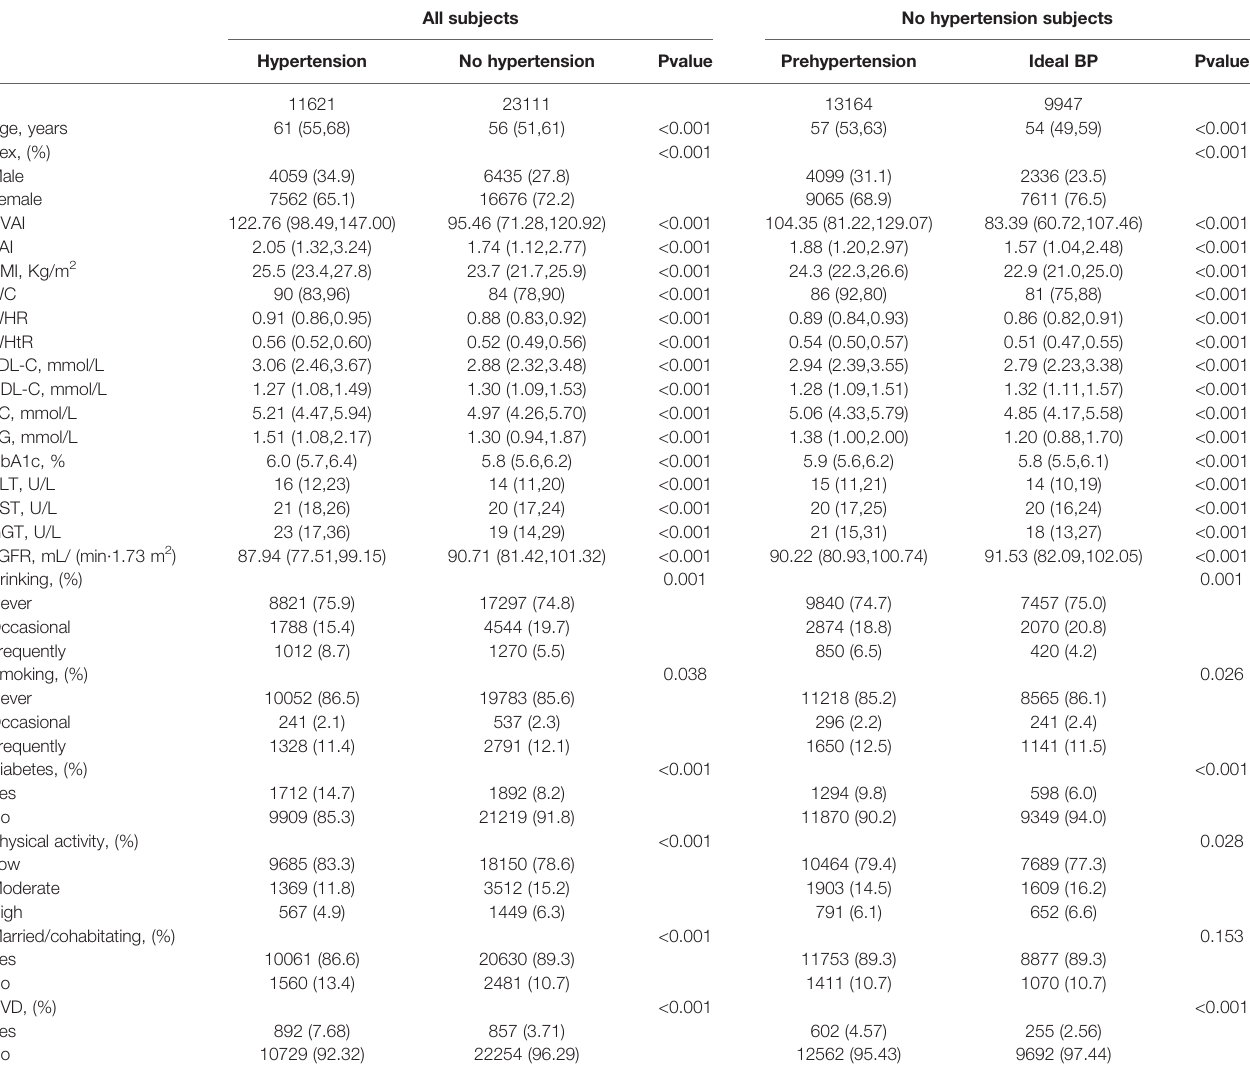
TABLE 1 | Characteristics of study population by hypertension or pre